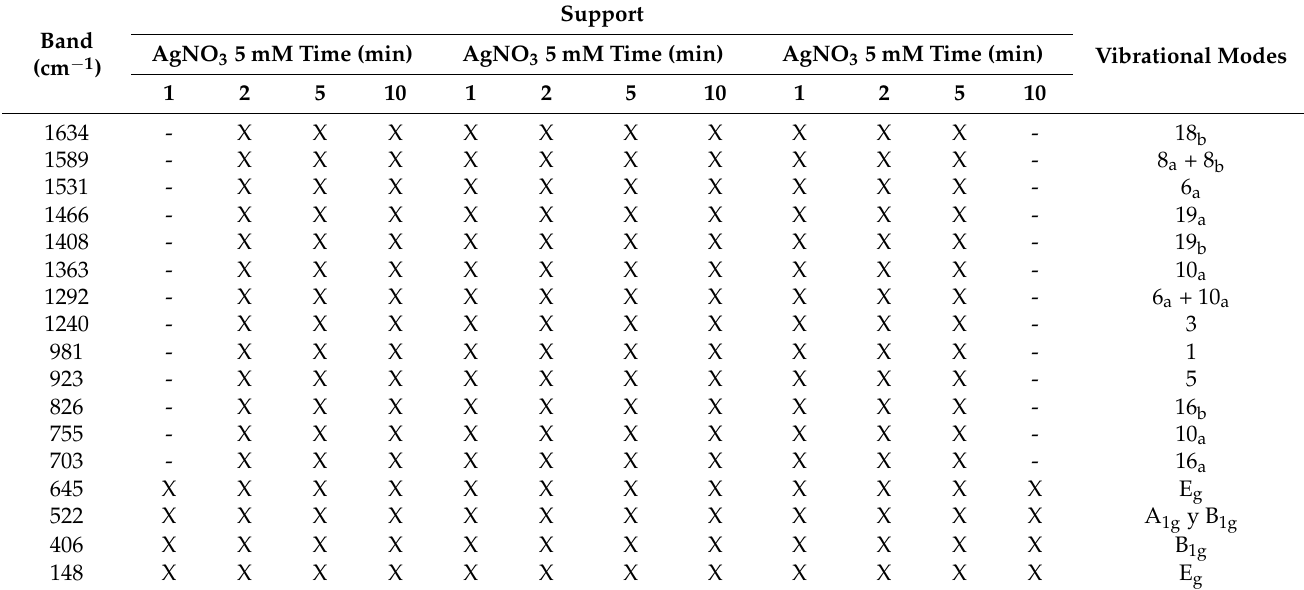
Table 4. Bands of Raman spectrum of the pyridine solution on the different SiO 2 –TiO 2 –Ag fiber supports, the bands observed in a wave number less than 645 cm − 1 belong to the anatase crystal structure of titania, the rest belong to pyridine. Cells marked with “X” indicate the presence of the band [3,30,31].